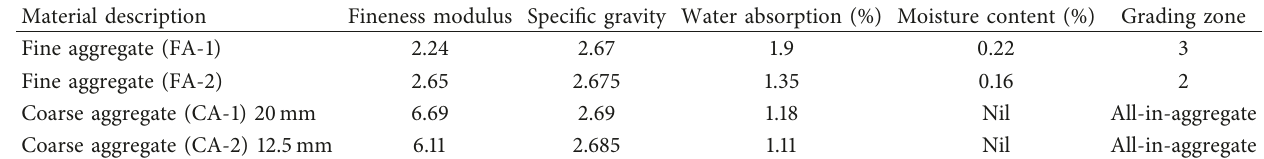
Table 1: Properties of fine and coarse aggregates.